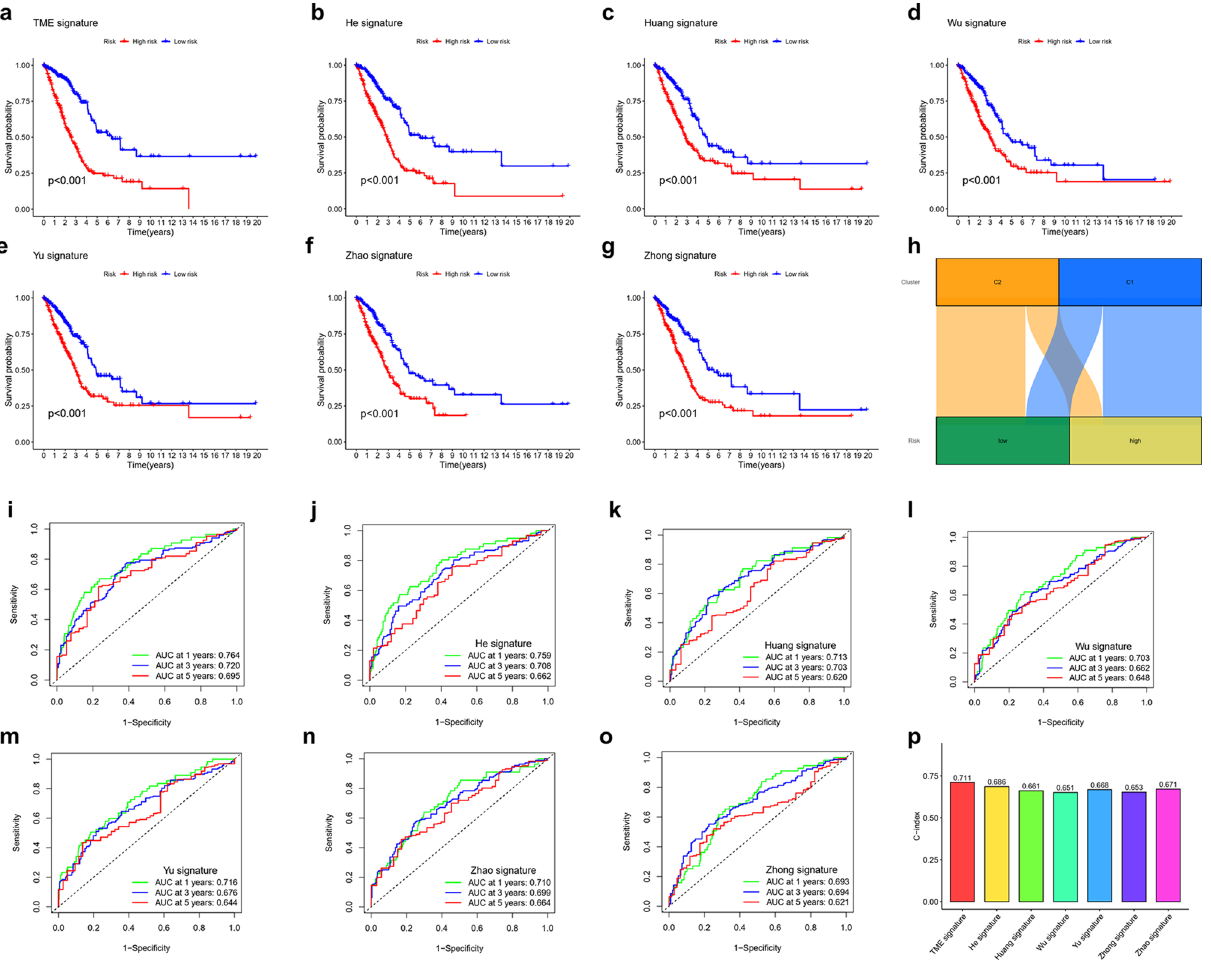
Figure 3. Comparing the TME signature with other models. Survival analysis of seven signatures ( a – g ). ( h ) The Sankey map of the two clusters compared with two groups. ROC curves of six signatures ( i – o ). ( p ) C-index of the seven prognostic risk